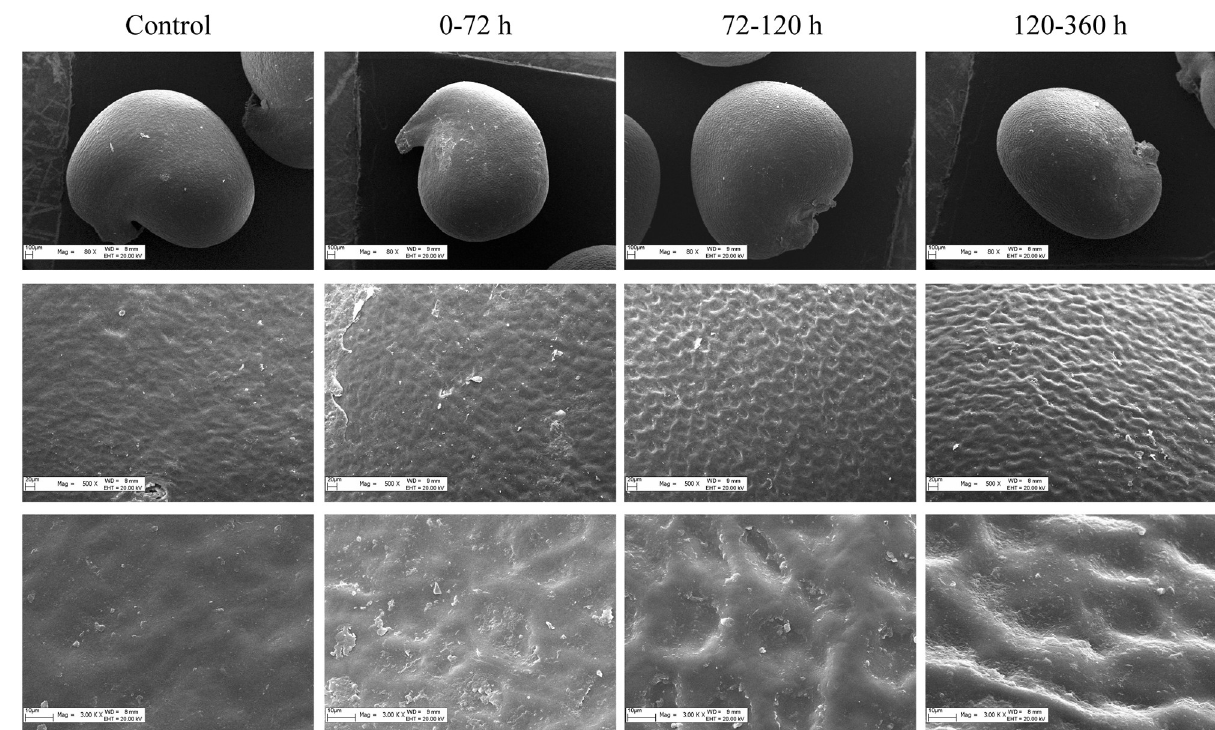
Fig 5. Effect of the DRT on C . spinosa seed coat morphology. The morphological changes of C . spinosa seed coats with different DRTs were observed by SEM with images magnified to 80 × , 500 × and 3000 × .